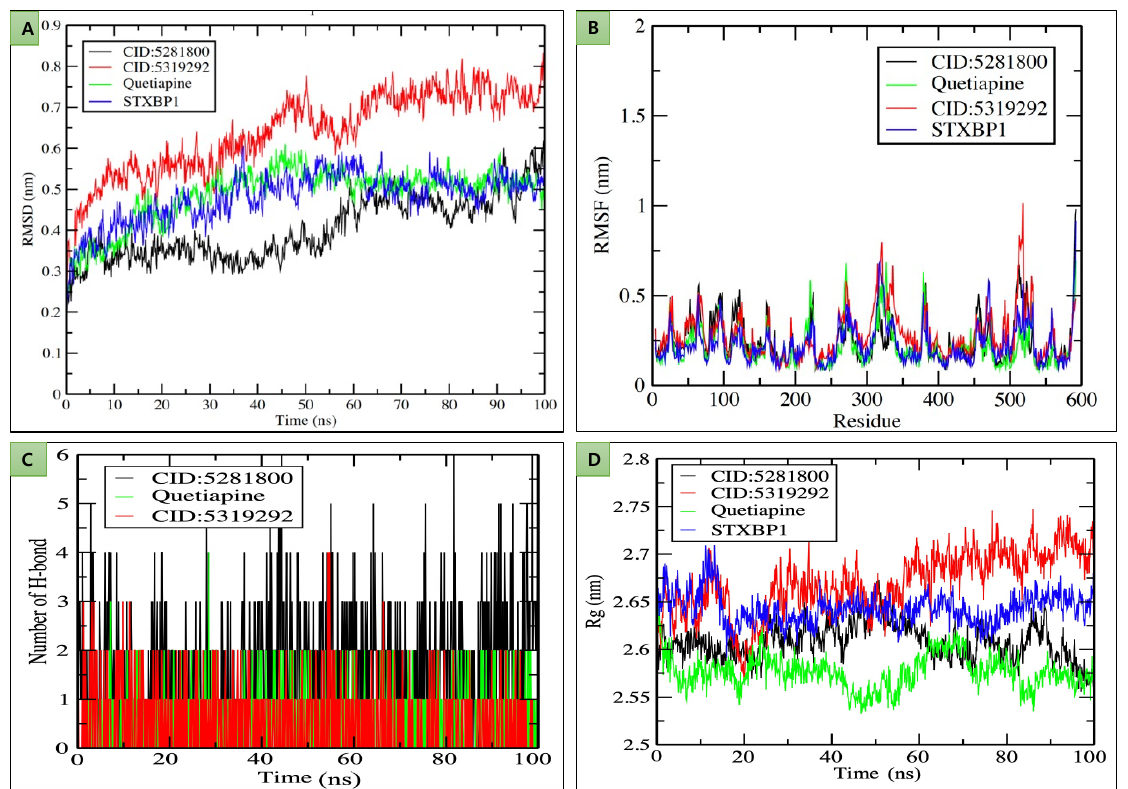
Figure 4. Graphical representation of ( A ) RMSD plot of STXBP1 in water (blue) STXBP1-CID:5281800 (black), STXBP1-CID:5319292 (red), STXBP1-Quetiapine (green) complexes deviation during 100 ns period; ( B ) RMSF plot with fluctuation per residues; ( C ) H bond plot representing the number of H bond during 100 ns period; ( D ) Rg plot representing compactness of receptor molecules in the presence of natural compounds and selected drug during 100 ns simulation. Where nm = nanometer; ns =